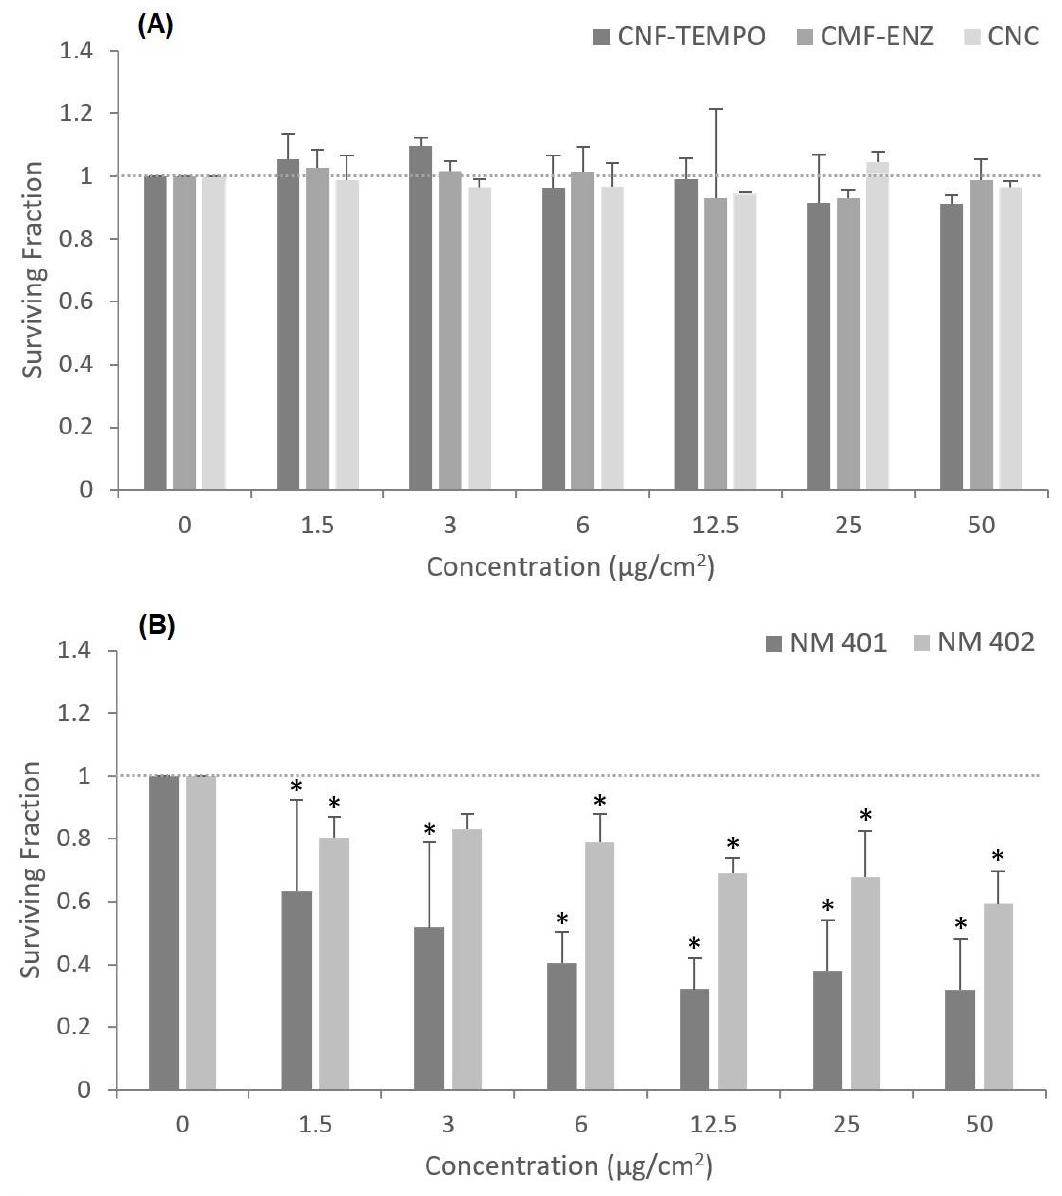
Figure 7. Effects of nanocellulose and MWCNT exposure (eight days) at different concentrations on colony formation of A549 cells: ( A ) CNF-TEMPO, CMF-ENZ, and CNC; ( B ) NM-401, NM-402. The results are expressed as mean ± SD of three independent experiments, each carried out in triplicate. * Denotes a statistically significant difference from the control ( p < 0.05).